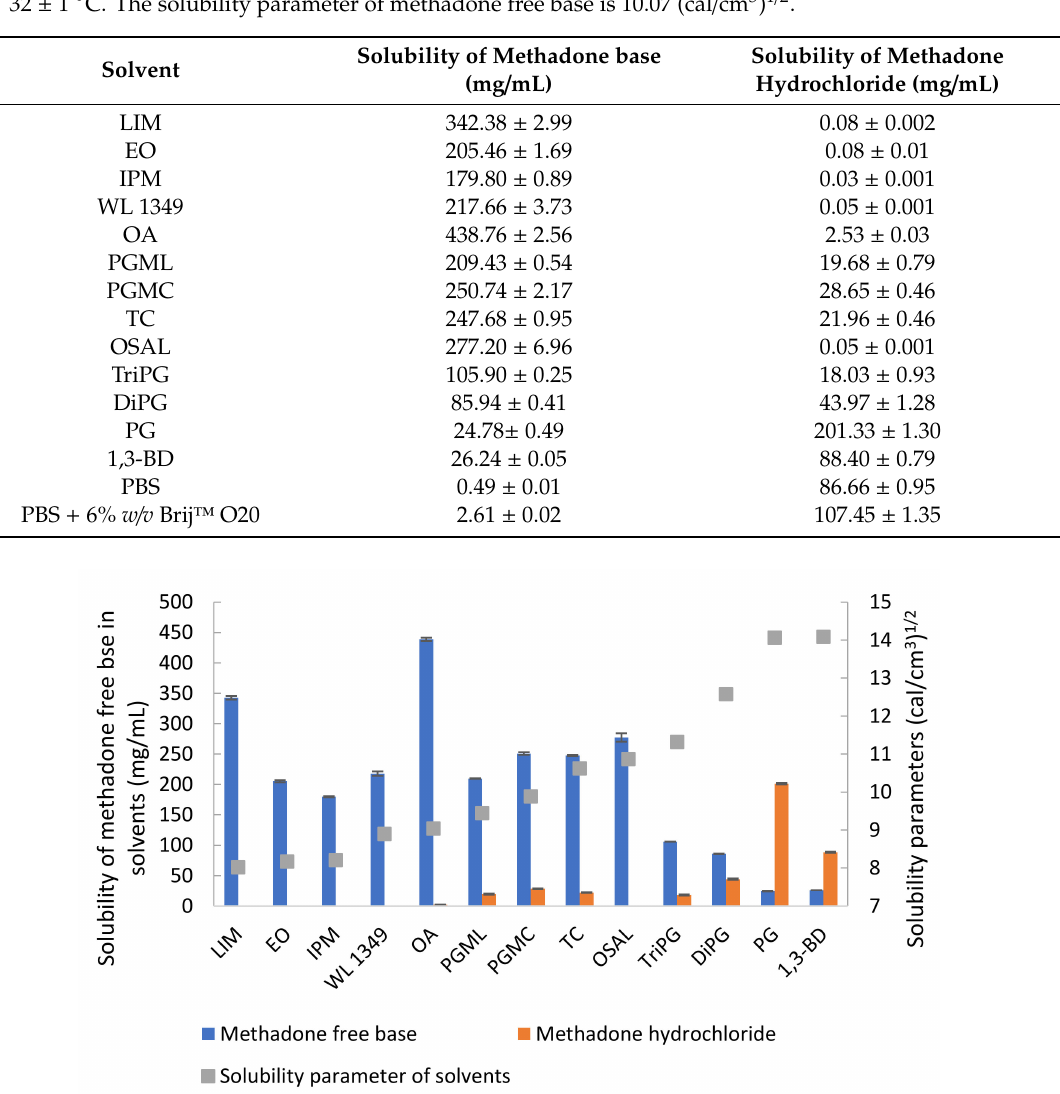
Table 2. Summary of the solubility of methadone hydrochloride and free base in neat solvents at